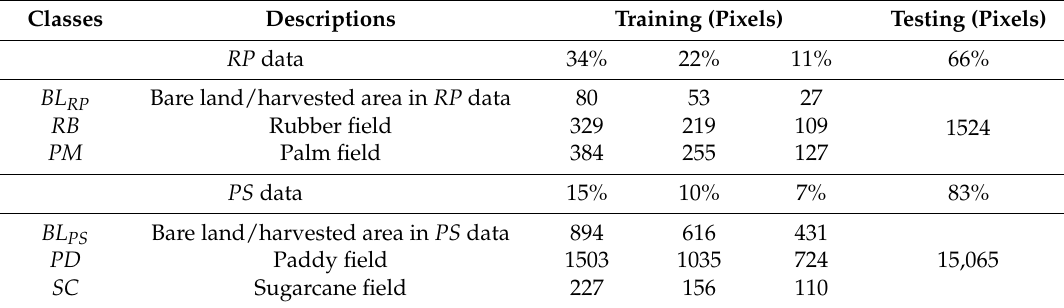
Table 1. Training and testing data.